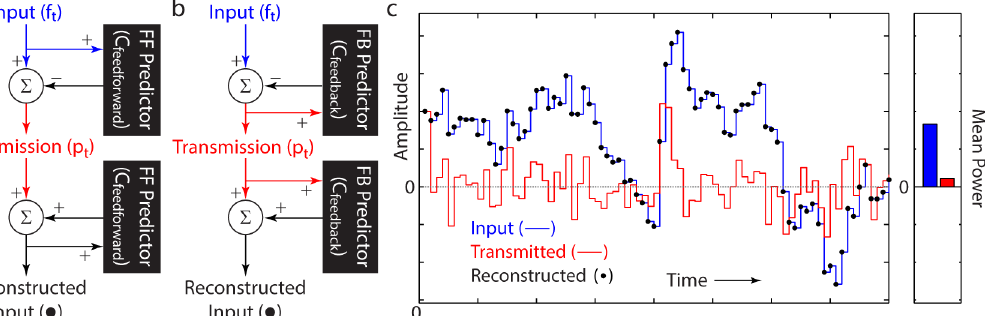
Fig 1. Lossless compression via predictive coding. Feedforward (a) and feedback (b) predictive coding circuits (as in Eq (1)), showing the circuit structure necessary for reconstructing the input. (c) Lossless reconstruction (black dots) of an input (blue) from the transmitted output of a predictive coding circuit (red). The mean power up to each point in time (solid bars) for the input (blue) and transmission (red) demonstrates the reduction in the mean transmitted power via predictive coding.